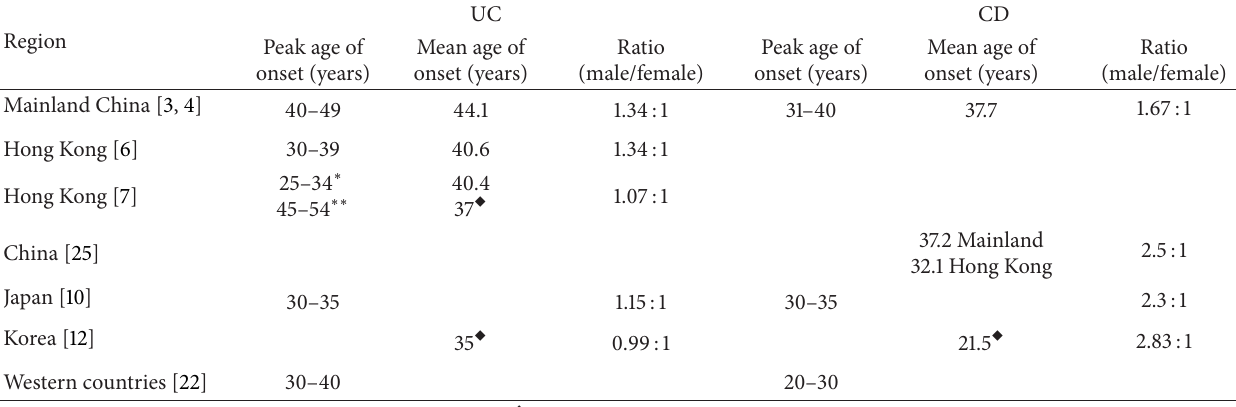
Table 3: Ages and gender distribution of UC and